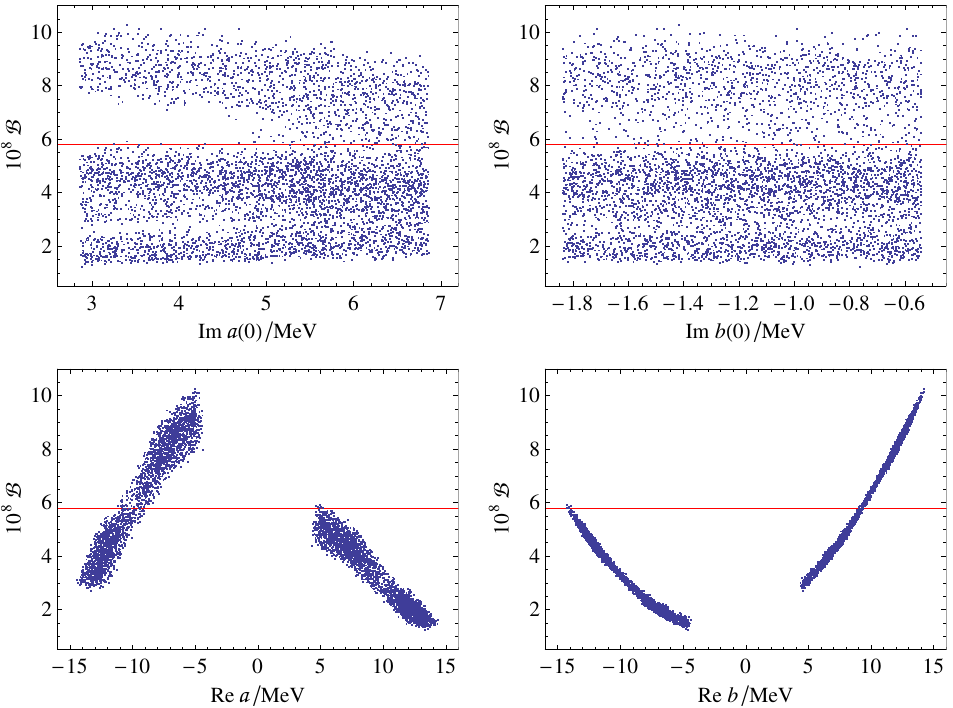
Figure 1 . Sample points of B ((cid:6) + ! p(cid:22) + (cid:22) (cid:0) ) (cid:2) 10 8 in relation to the preferred ranges of Im( a; b ) at q 2 = 0 and of Re( a; b ), as explained in the text. Each horizontal red line marks the 2 (cid:27) upper-limit of the LHCb measurement [2].